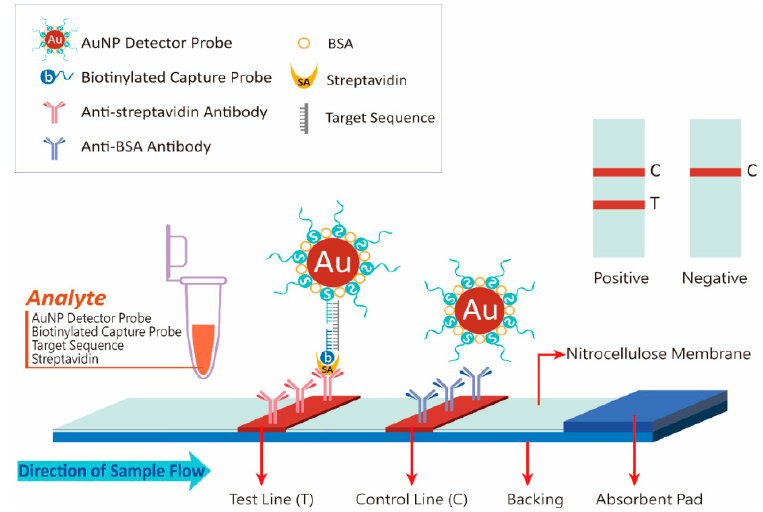
Figure 1. Schematic of the developed lateral flow strip.